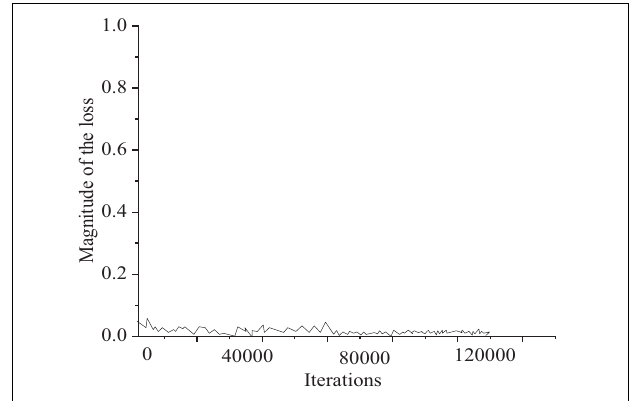
FIGURE 6 | Loss curve of note onset detection in the network training